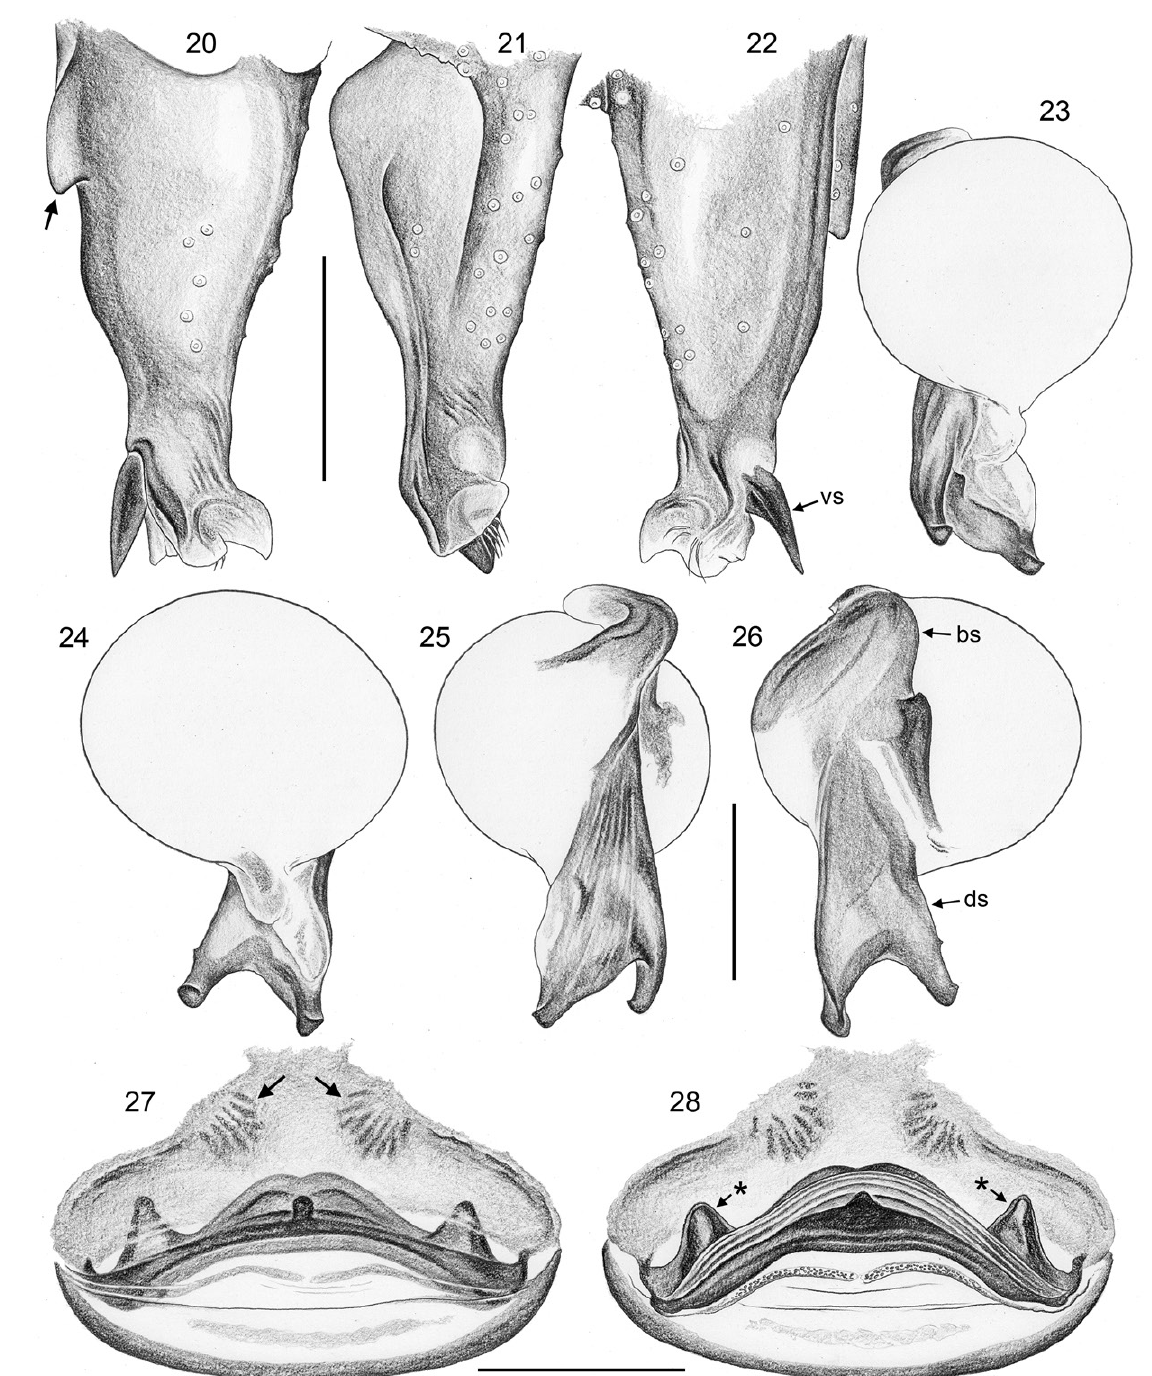
Figs 20–28. Holocnemus pluchei (Scopoli, 1763); male from Israel, S of Teverya (ZFMK Ar 22306), female from Georgia, Sighnaghi (ZFMK Ar 21373). 20–22 . Left procursus, prolateral, dorsal, and retrolateral views; arrow: prolateral-ventral process. 23–26 . Left genital bulb, ventral, prolateral, dorsal, and retrolateral views. 27–28 . Cleared female genitalia, ventral and dorsal views; arrow: pair of sculptured areas; asterisks: pair of internal pockets. Abbreviations: bs = basal sclerite; ds = distal sclerite; vs = ventral sclerite. Scale bars: 20–26 = 0.3 mm; 27–28 = 0.5